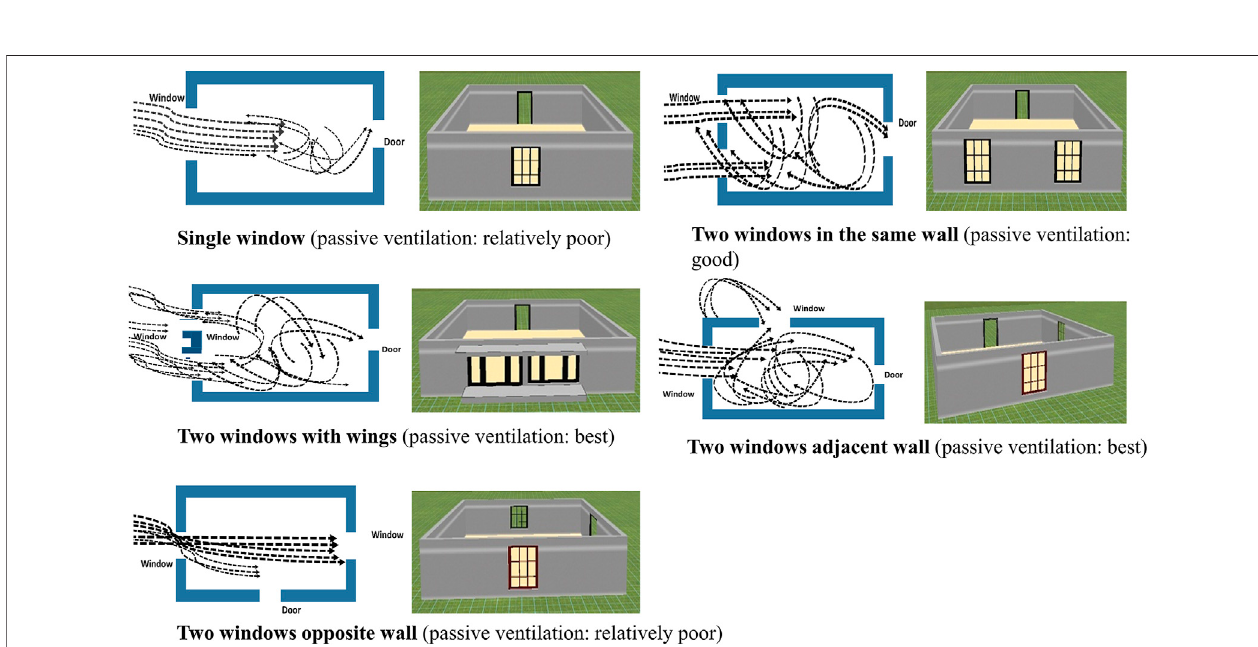
FIGURE 8 | Types of window patterns and schematic architectural strategies for passive ventilation in an indoor environment (redrawn from Brown and DeKay, 2001).